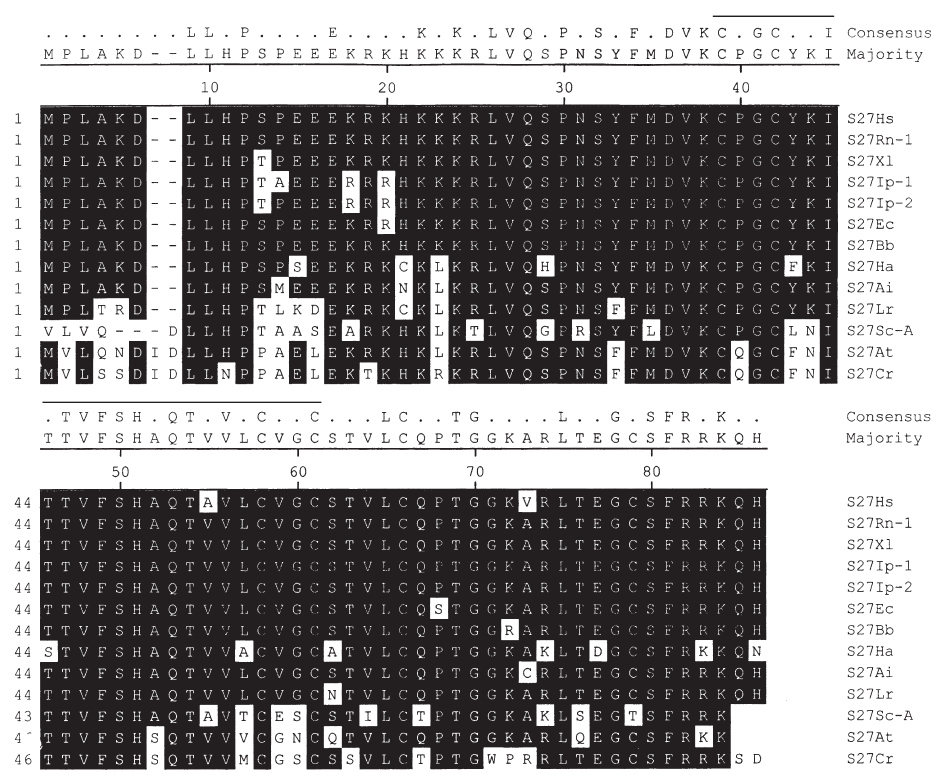
Figure 2 - Amino acid sequence alignment of representative S27 proteins using the MegAlign (DNASTAR) and CLUSTAL programs. The amino acid residues that match the consensus sequence are shaded solid black. Gaps introduced into sequences to optimize the alignments are represented by (-). The consensus sequence is provided above the multiple alignments and the zinc finger-like motif is underlined.